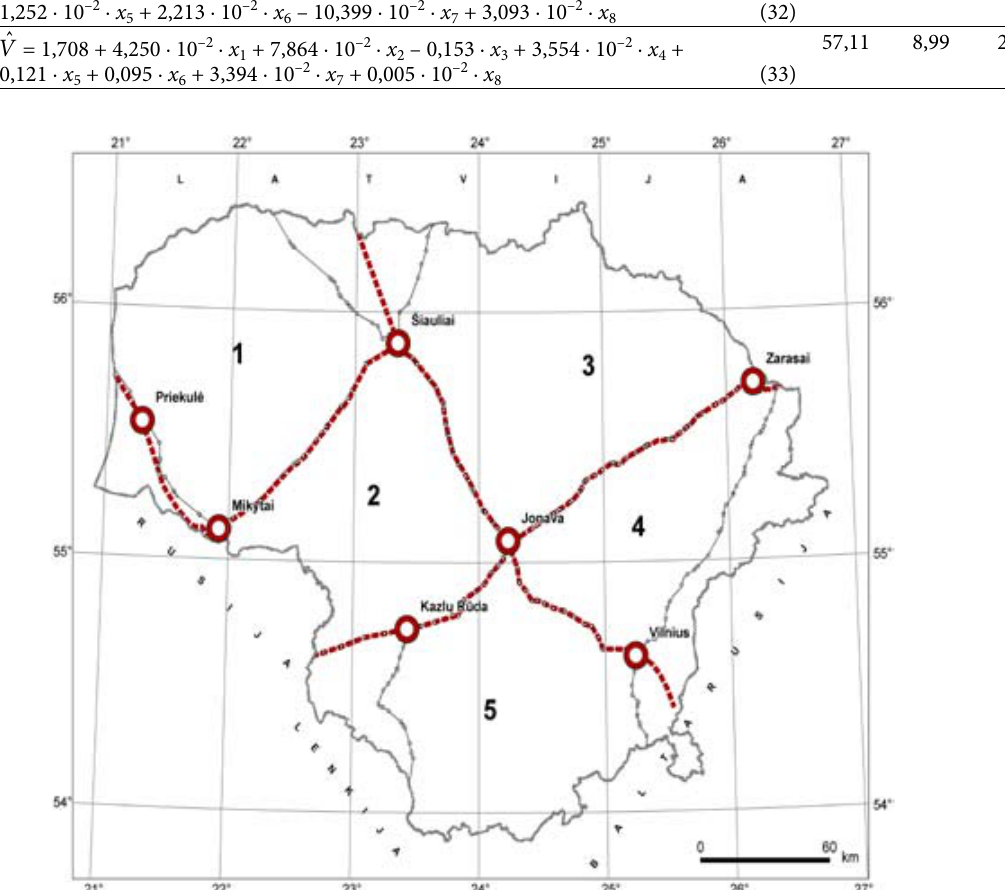
Fig. 3. Scheme of polygons node